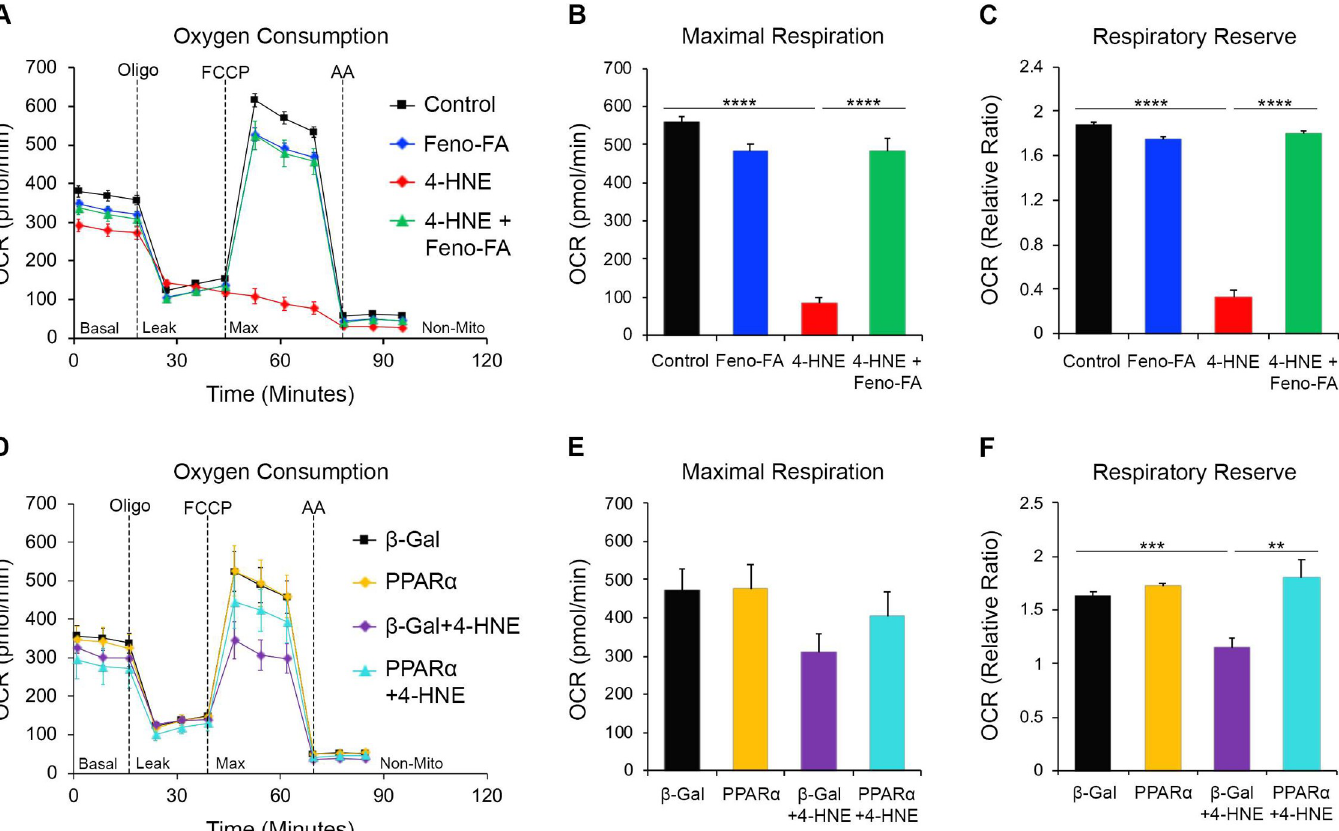
Fig 5. PPAR α restores mitochondrial respiration in vitro . (A-C) Seahorse extracellular flux analysis of R28 cells revealed that (B) maximal respiration and (C) respiratory reserve capacity were decreased by 4 hours exposure to 15 μ M 4-Hydroxynonenyl (4-HNE), and restored by a 2-hour pretreatment with 25 μ M fenofibric acid (Feno-FA) prior to 4-HNE exposure (n = 5 /group). (D-F) Seahorse extracellular flux analysis of adenovirus-infected R28 cells revealed that (E) maximal respiration was non-significantly decreased by 4 hours exposure to 15 μ M 4-HNE in cells infected with β -Galactosidase-expressing adenovirus (Ad- β -Gal), and partially restored by infection with PPAR α -expressing adenovirus (Ad-PPAR α ), and (F) respiratory reserve capacity was significantly decreased by 4 hours exposure to 15 μ M 4-HNE in Ad- β - Gal infected cells, and restored in 4-HNE-exposed Ad-PPAR α -infected cells ( β -Gal n = 5, PPAR α n = 5, β -Gal + 4-HNE n = 5, PPAR α + 4-HNE n = 4). In both experiments, 1 μ M oligomycin was injected when indicated in A and D to determine proton leak, 2 μ M FCCP was injected as indicated to uncouple (maximize) mitochondrial respiration, and 1 μ M antimycin A (AA) was injected at the end of the experiment to arrest mitochondrial respiration. �� p � 0.01; ��� p � 0.001; ���� p � 0.0001, One-way ANOVA with Tukey’s post-hoc